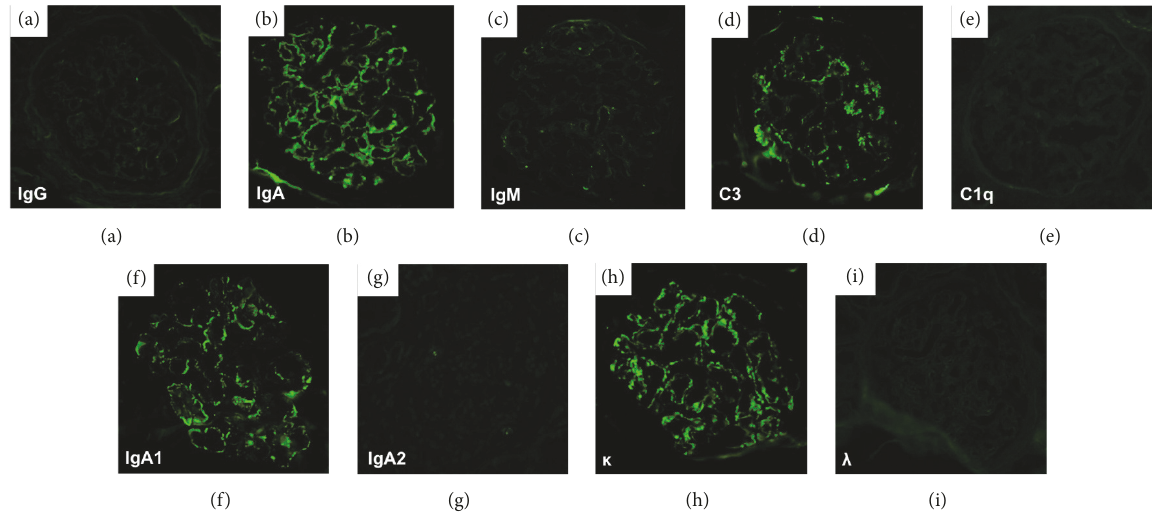
Figure 2: Immunofluorescence microscopy findings. Fluorescent immunostaining showed positive staining for IgA and C3, whereas IgG, IgM, and C1q staining were negative. Fluorescent immunostaining of IgA subtypes and light chains showed positive staining for IgA1 and 𝜅 light chains, while staining for IgA2 and 𝜆 light chains was negative.